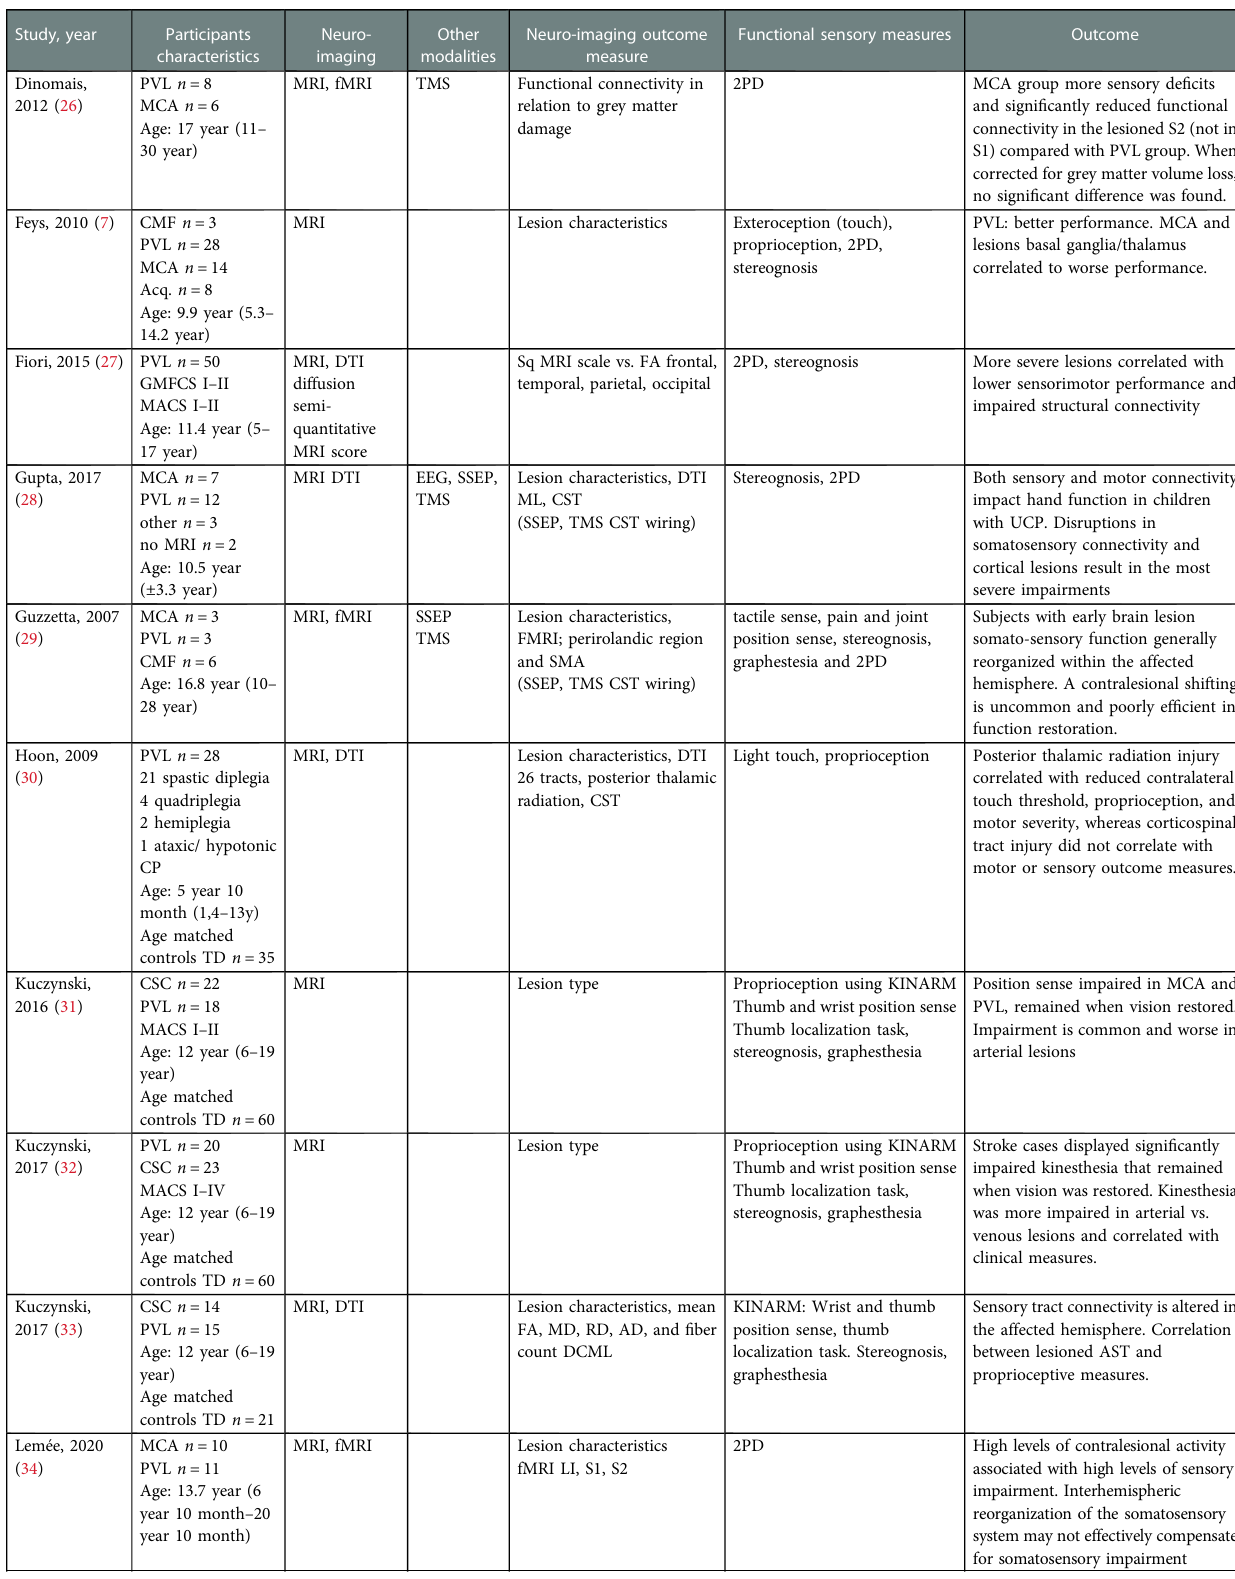
TABLE 1 Included studies in systematic review. Study,